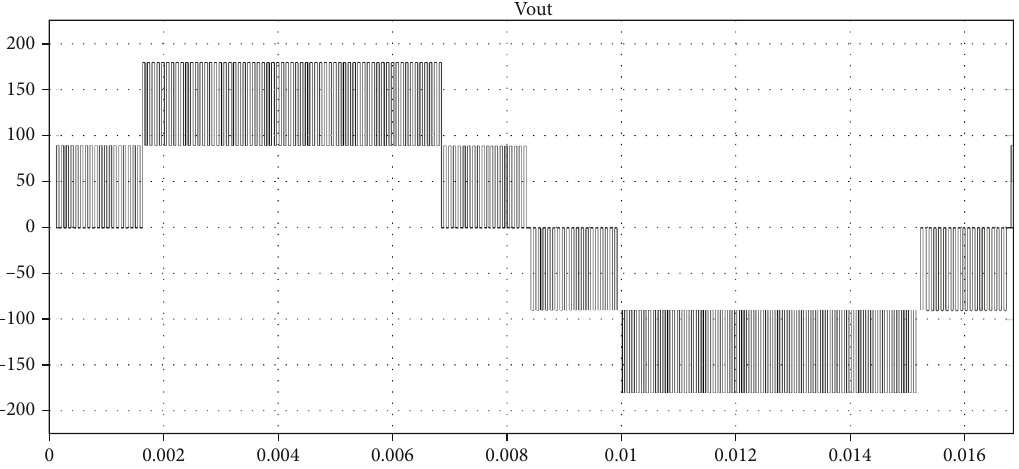
Figure 6: Output voltage waveform of proposed inverter without LC fi lter.